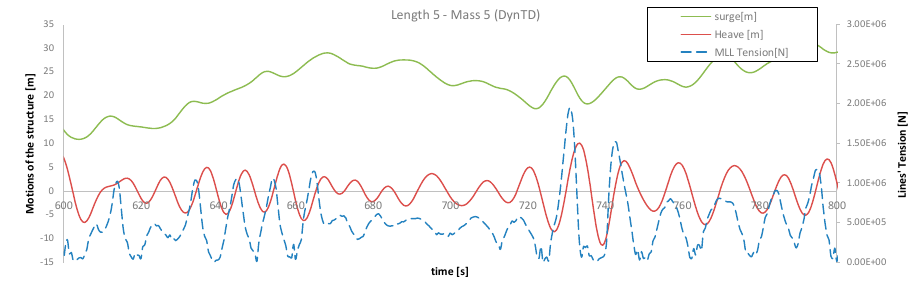
Figure 14. Time series extract of buoy heaving and the corresponding tension of the most loaded line.